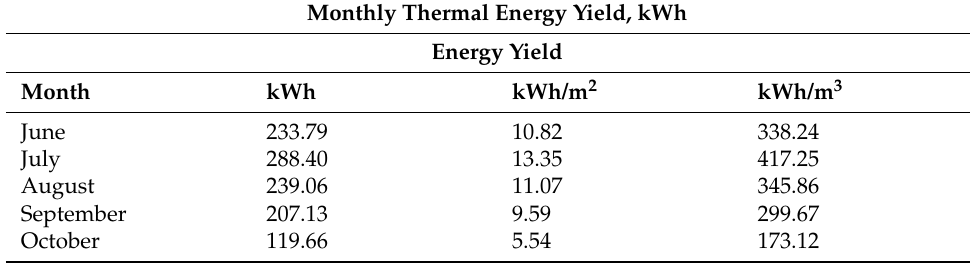
Table 3. Thermal energy yield (June—October